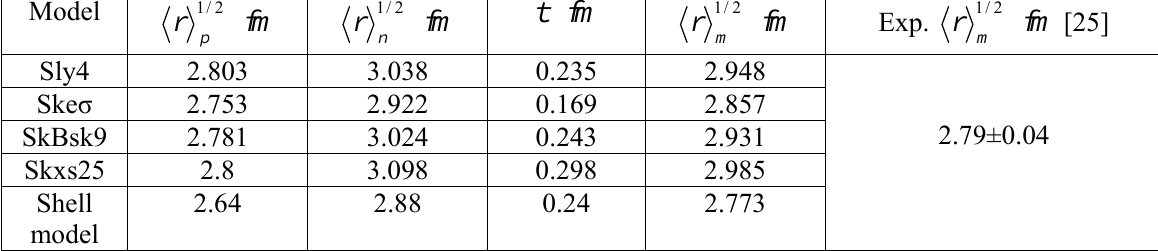
Table 2: The values of rms radii in fm of 23 F nucleus.